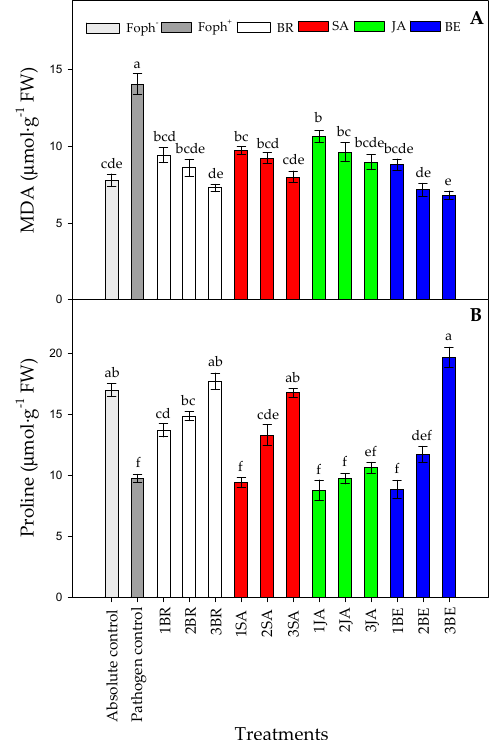
Figure 9. Effect of the different number of sprays (0, 1, 2 and 3 applications) of synthetic elicitors (Salicylic acid (SA), jasmonic acid (JA), Brassinosteroids (BR), or botanical extracts (BE)) on malondialdehyde (MDA) ( A ) and proline content ( B ) in Fusarium oxysporum f. sp. physali (Foph + ) infected cape gooseberry ( Physalis peruviana L.) plants at 50 DAI. Data represent the average of ten plants ± SE per treatment ( n = 10). Bars followed by different letters indicate statistically significant differences according to the Tukey test ( p ≤ 0.05).